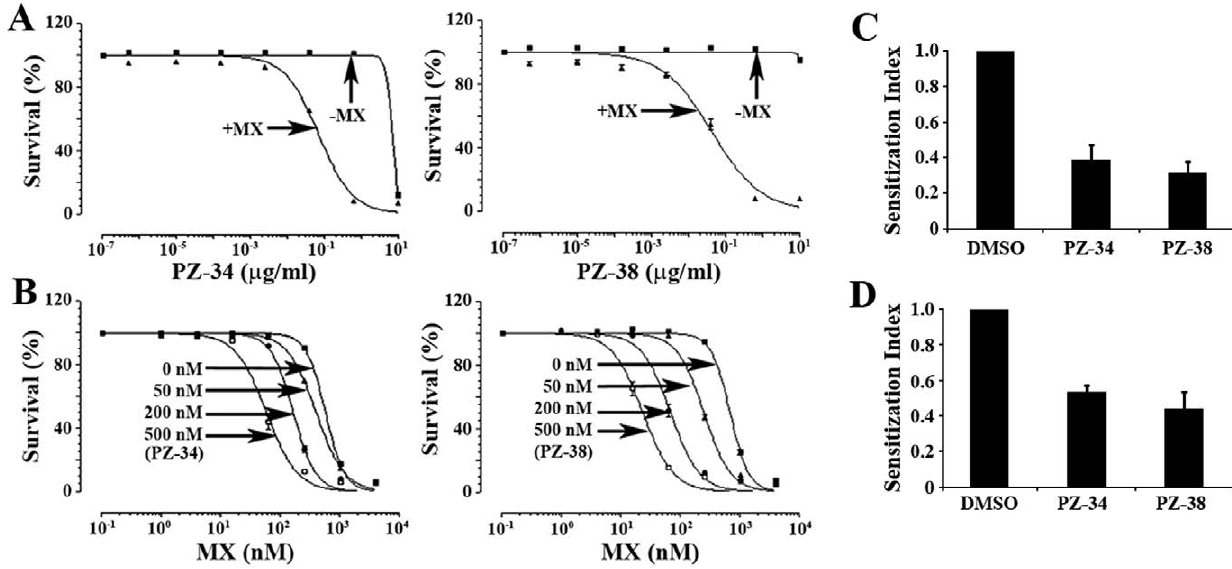
Figure 5. Effect of PZ-34 and PZ-38 on sensitizing drug resistance. A, potency of PZ-34 and PZ-38 in reversing mitoxantrone resistance. HEK293/ABCG2 cells were treated without or with 0.1 m M (IC 10 ) mitoxantrone in the absence or presence of different concentrations of PZ-34 or PZ- 38 followed by SRB assay. B, sensitization index of PZ-34 and PZ-38 in HEK293/ABCG2 cells. HEK293/ABCG2 cells were treated with various concentrations of mitoxantrone in the absence or presence of different concentrations of PZ-34 or PZ-38 followed by SRB assay. C and D, sensitization index of PZ-34 and PZ-38 in drug-selected MCF7/AdVp3000 cells. MCF7/AdVp3000 cells were treated with various concentrations of mitoxantrone (C), or Adriamycin (D) in the presence of DMSO (vehicle) or 500 nM of PZ-34 and PZ-38 followed by MTT assay. Sensitization index was calculated using IC 50 of the anticancer drugs in the absence or presence of PZ-34, PZ-38, or FTC. The data shown are mean 6 SD of three independent experiments.